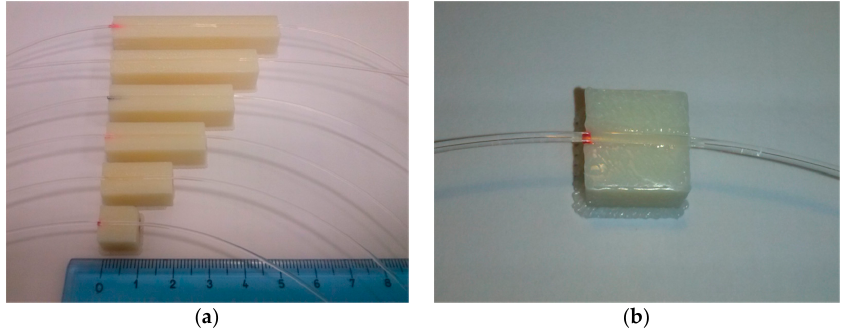
Figure 1. D-shaped sensors: ( a ) lengths of the sensing region ranging from 1 cm (Sensor 1) to 6 cm (Sensor 6); ( b ) Close-up of Sensor 1, with sensing region of 1 cm length.